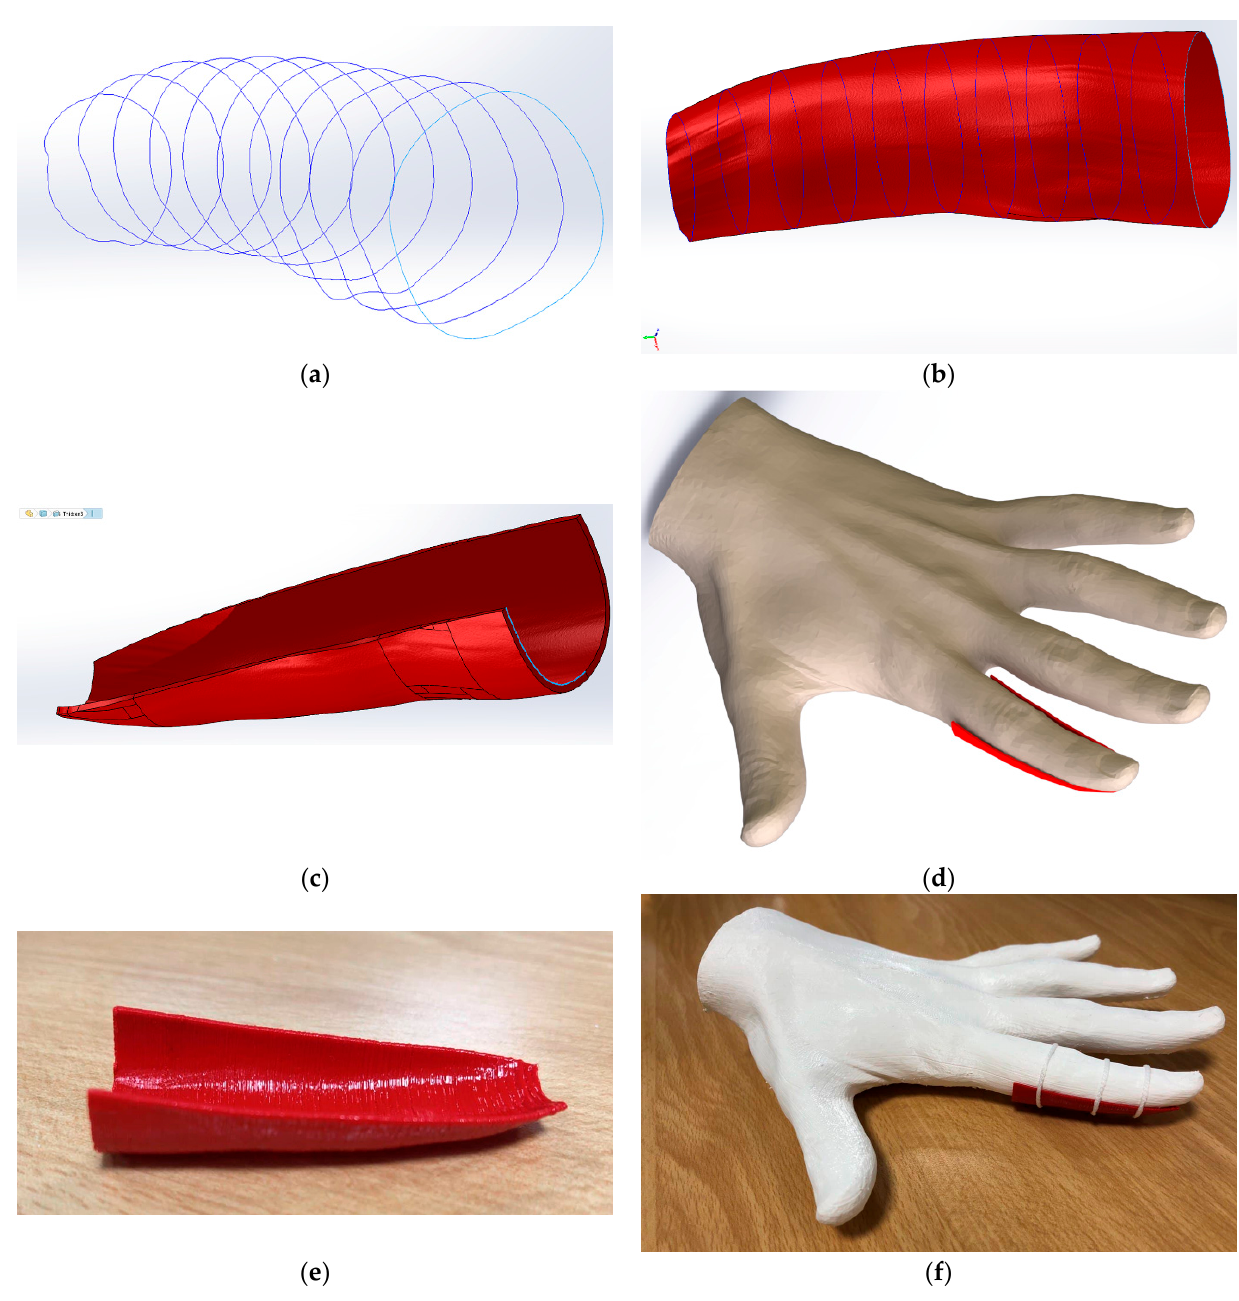
Figure 6. User-tailored forefinger orthosis: ( a ) Boundaries of the forefinger uploaded to SolidWorks software (SolidWorks version 2018, Dassault Systèmes, S.A., Suresnes, France); ( b ) Boundary surface generated for the forefinger orthosis; ( c ) Orthosis solid body with a thickness of 1 mm; ( d ) Forefinger orthosis computer aided design (CAD) image dressing used on a human hand; ( e ) Printed user-tailored forefinger orthosis; ( f ) Forefinger orthosis dressing on a 3D printed sample of the human hand model used for the design process.